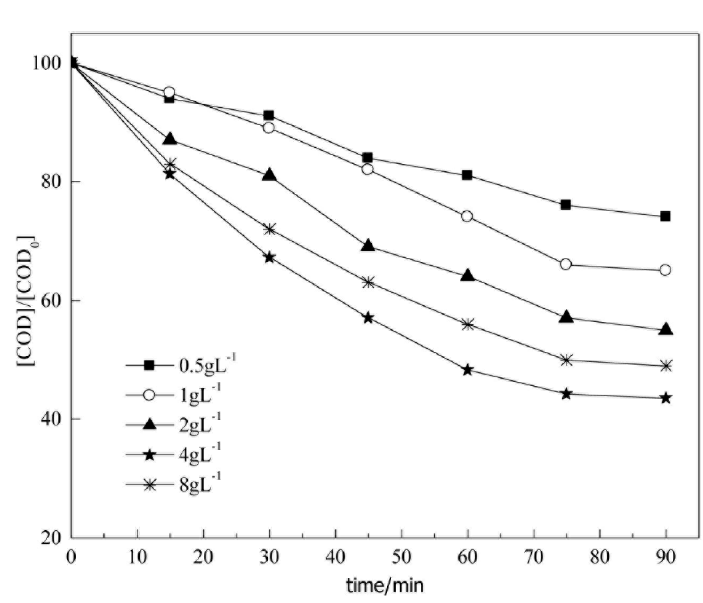
Figure 11. Effects of iron ion concentration.